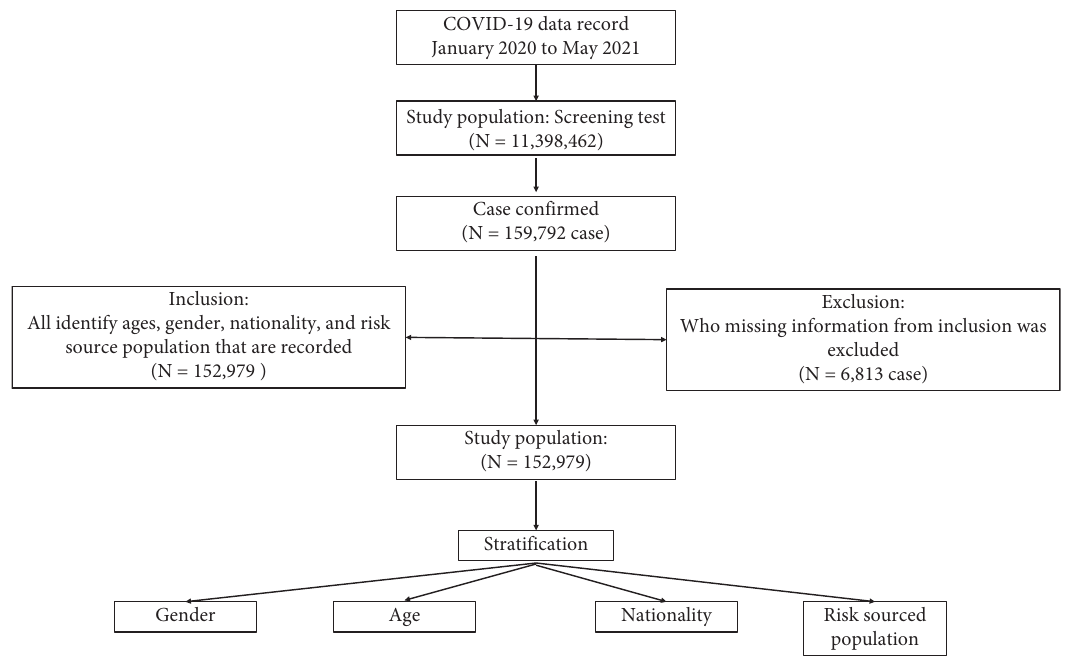
Figure 1: Derivation of the study population. Table 1: Cases and deaths across phases and waves during the COVID-19